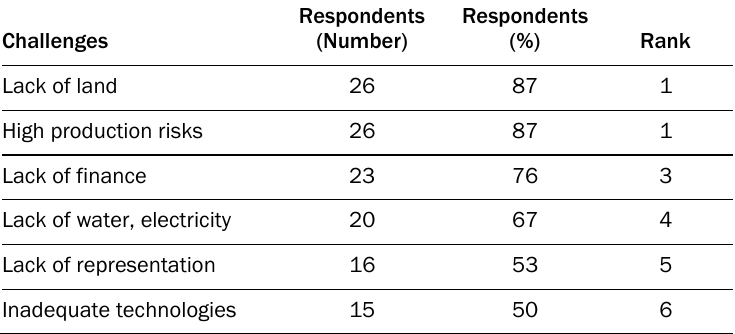
Table 3. Challenges to Urban Agriculture According to Survey